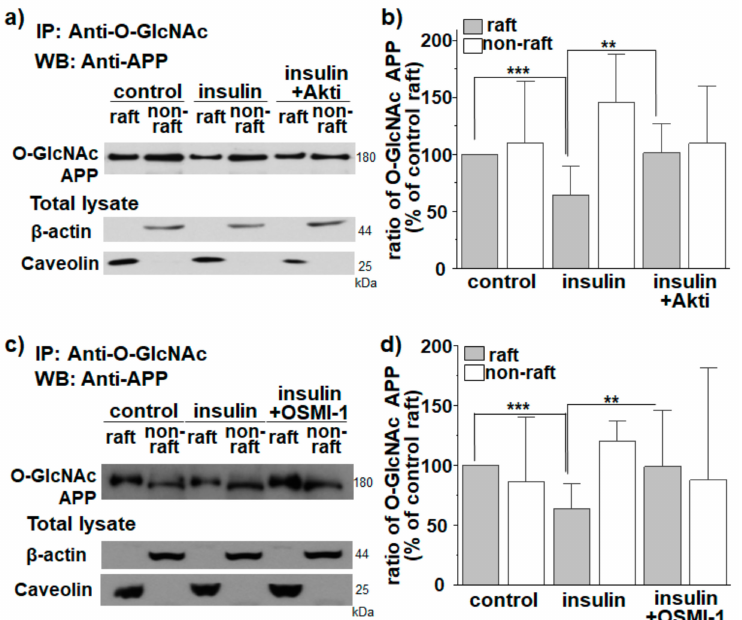
Figure 3. Effect of insulin on APP localization in lipid rafts occurs via Akt signaling and OGT. SH- SY5Y-APP/BACE1 cells were incubated with 1 µ M insulin for 2 h. Akt inhibitor (Akti, 10 µ M) or OGT inhibitor (OSMI-1, 50 µ M) was also used. O-GlcNAc APP levels were compared to O-GlcNAc APP levels in raft fraction of control cells. ( a , b ) The effect of insulin on the localization of O-GlcNAcylated APP in lipid rafts in the presence of Akti ( n = 7, number of independent experiments). ( c , d ) The effect of insulin on localization of O-GlcNAcylated APP in lipid rafts in the presence of OSMI-1 ( n = 7, number of independent experiments). Caveolin was used as a lipid raft marker. One-way ANOVA: **, p < 0.01; ***, p < 0.001. All values represent the mean ±